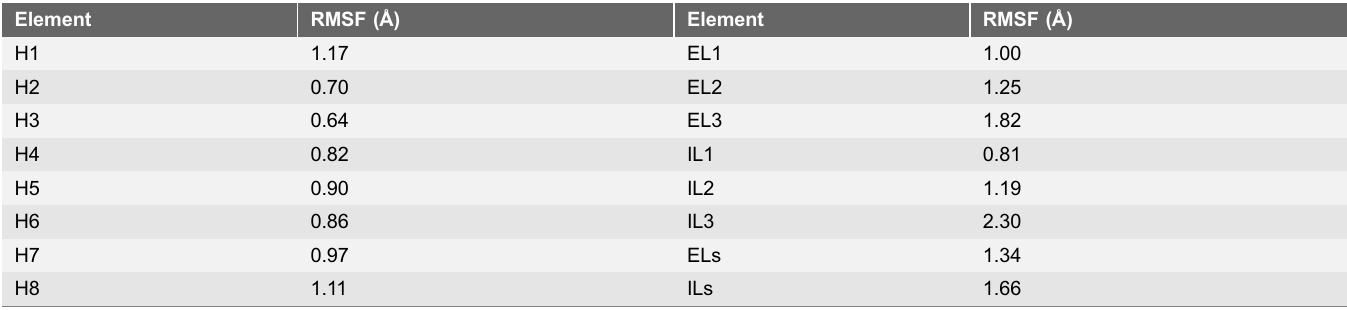
Table 2. Mean Root Mean Square Fluctuation (RMSF) computed for the C a atoms of the m OR backbone from the 0.5 m s all-atom MD simulation. Element RMSF (A˚ ) Element RMSF (A˚